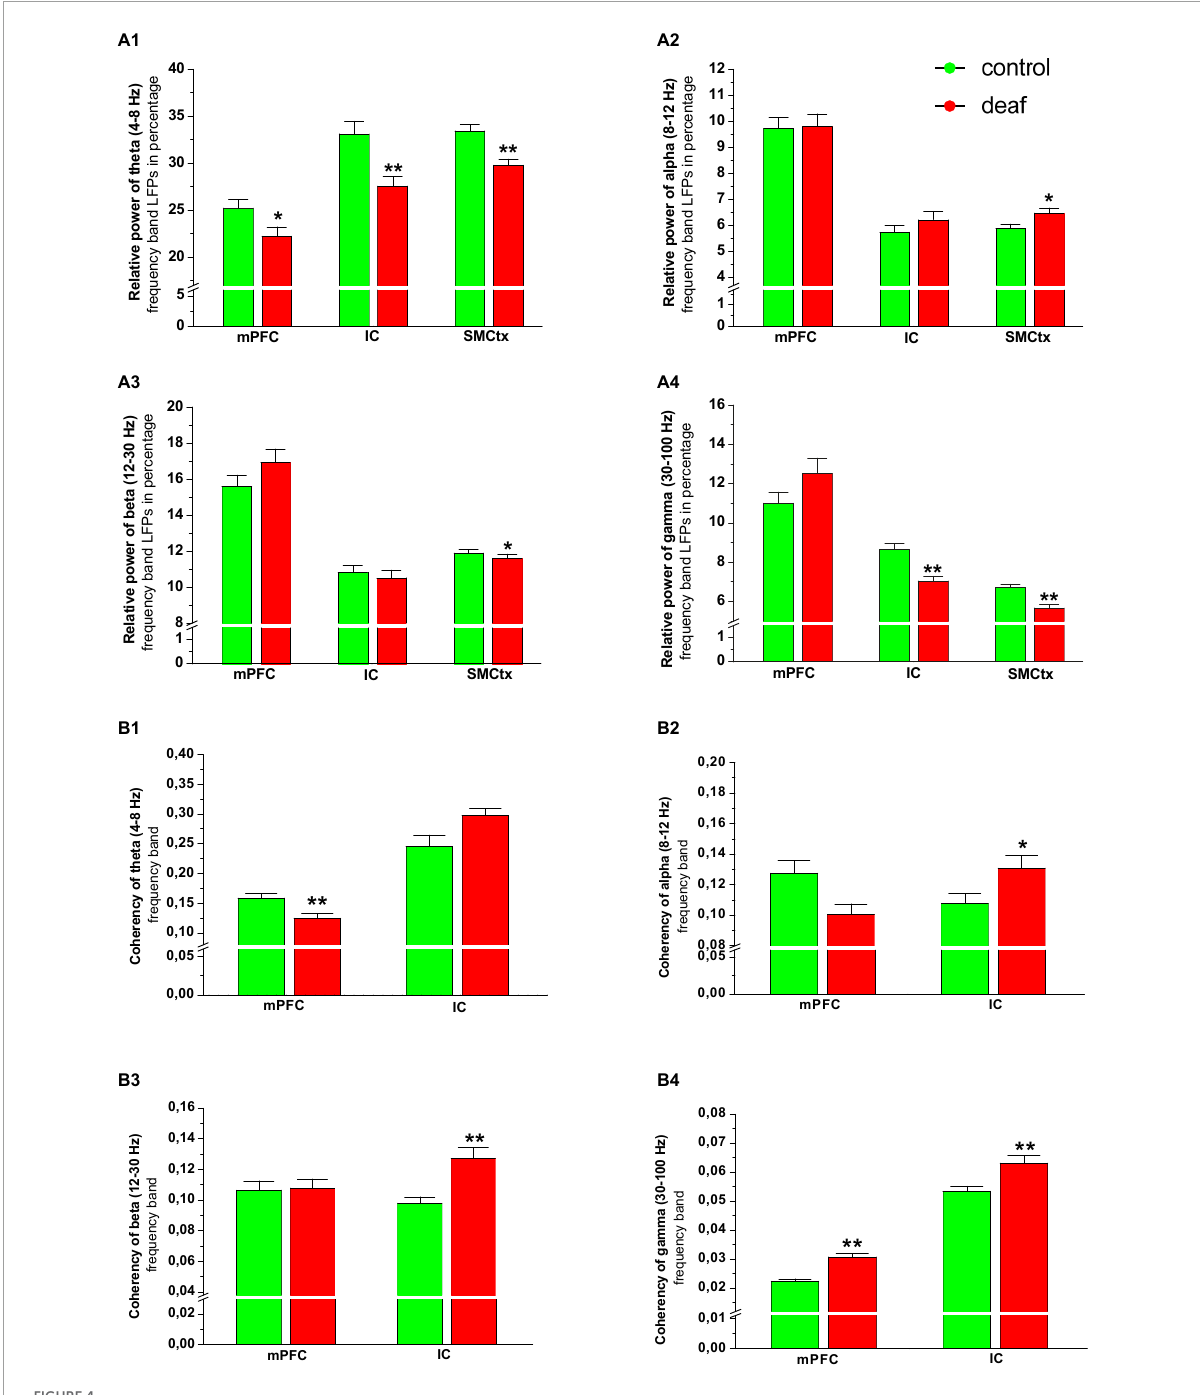
FIGURE4 Relative power of theta (A1) , alpha (A2) , beta (A3) , and gamma (A4) oscillatory activity in the mPFC and IC area, as well as their coherence with SM-CtxECoG in the theta (B1) , alpha (B2) , beta (B3) , and gamma (B4) band shown as mean ± S.E.M. for deaf and sham or naïve controls. Differences between deaf rats and controls are shown as asterisks (* P <